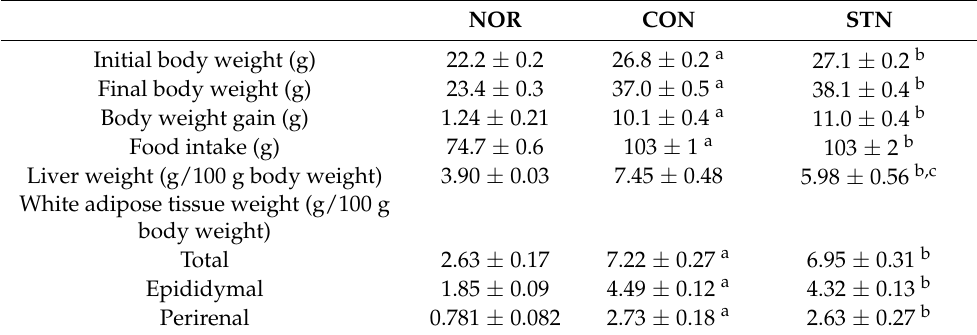
Table 2. Effect of experimental diet on growth parameters in C57BL/6J and db/db mice.